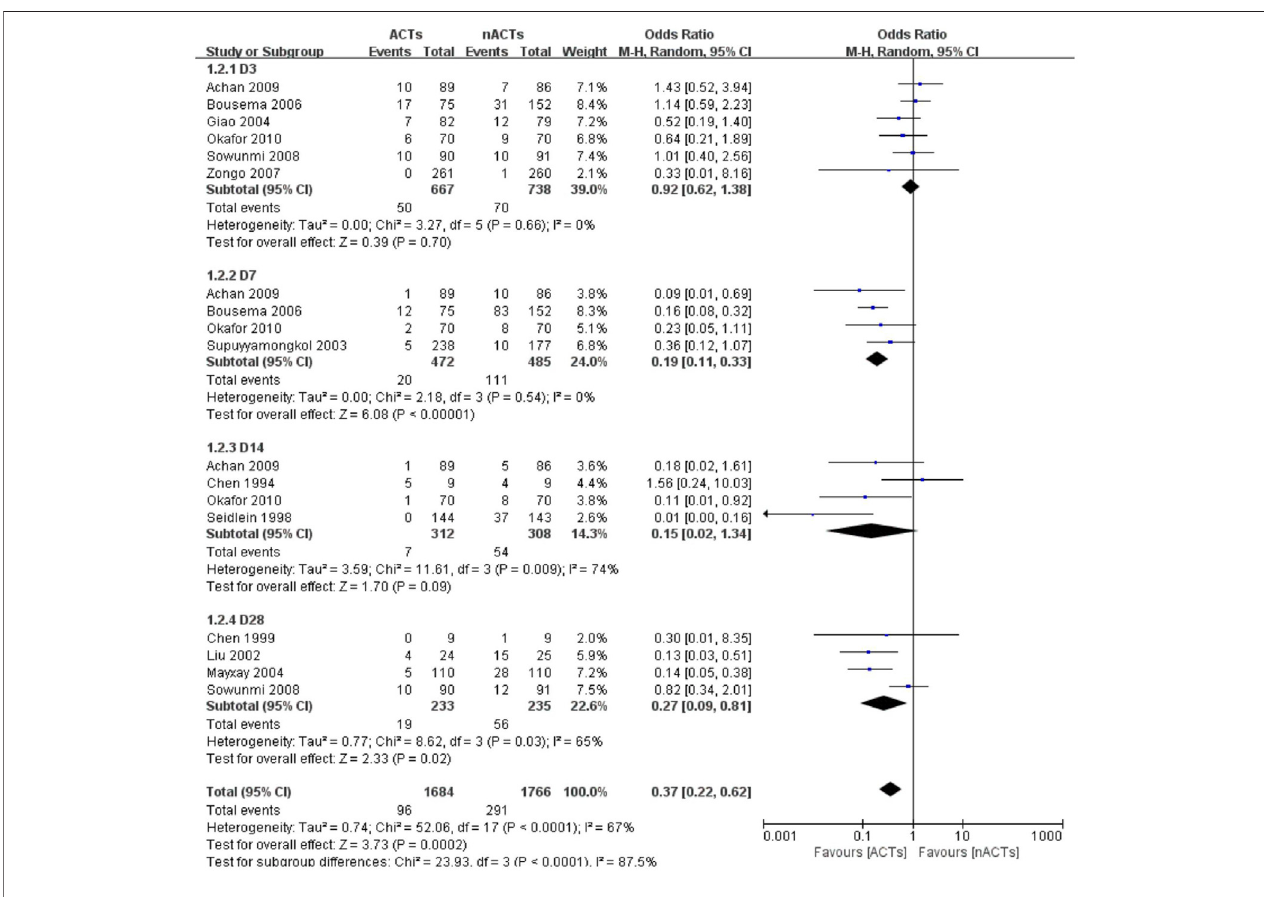
FIGURE 2 | Gametophyte carrying in the patient.